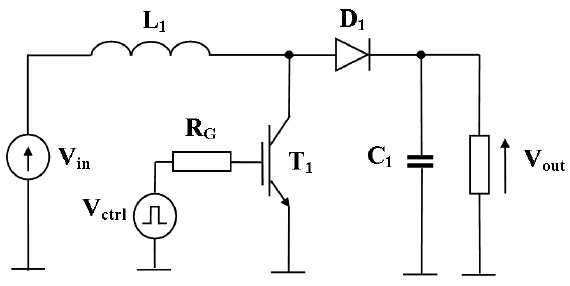
Figure 1. Diagram of a boost converter.